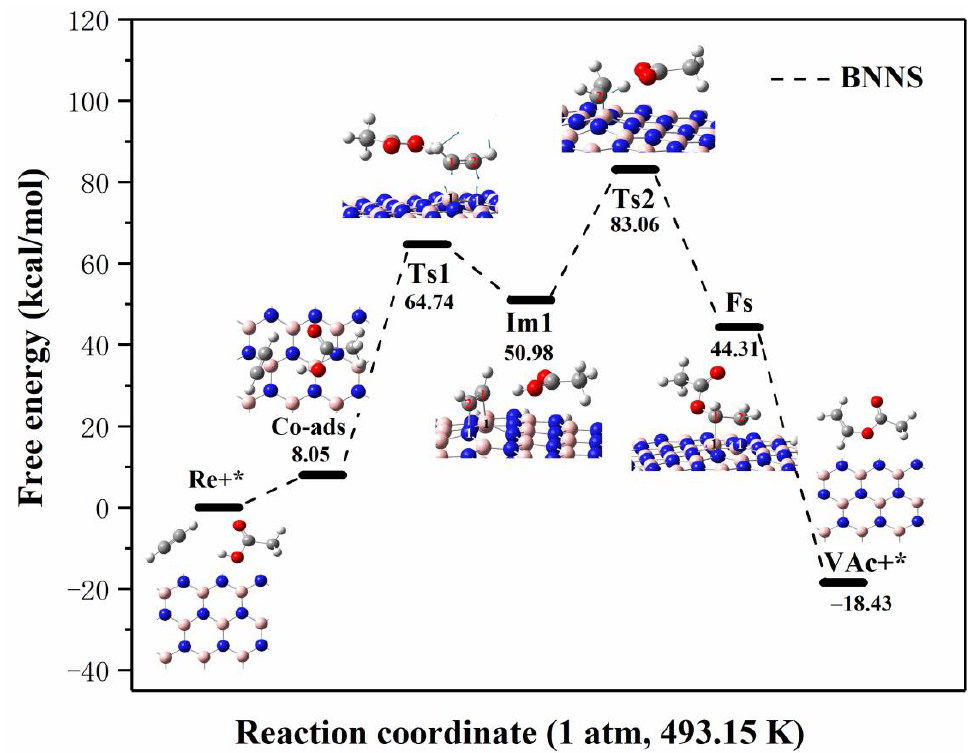
Figure 6. Reaction process and energy change of C 2 H 2 and CH 3 COOH on BN nanosheets at 1 atm and 493.15 K (Re stands for reactant, * stands for catalyst, Co-ads stands for co-adsorption structure, Ts stands for transition state, Im stands for intermediate state, Fs stands for final state structure, VAc stands for vinyl acetate).